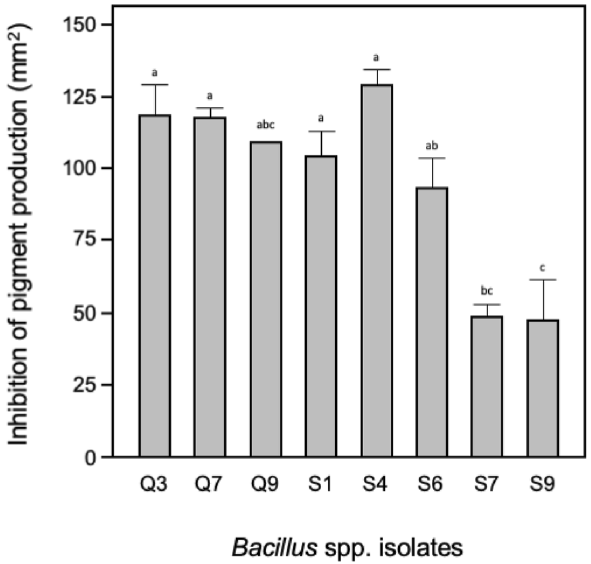
Figure 1. QQ graph. Isolates are shown on the x-axis. Means ± SE are shown on the y-axis; means not connected by the same letter are significantly different (TK-HSD, α =